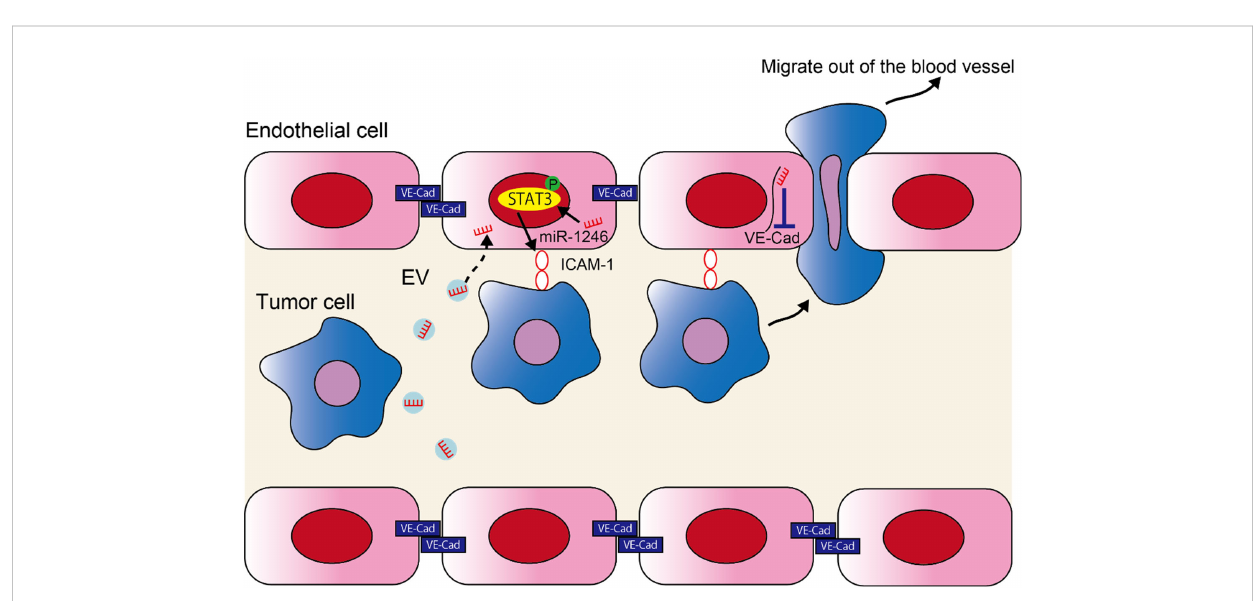
FIGURE 5 miR-1246 in high metastatic tumor EVs promotes metastasis by promoting the adhesion of tumor cells and destruction of the EC barrier. A schematic diagram of the study. miR-1246 released from high metastatic tumor cells via EVs is taken up by ECs and induces ICAM-1 expression via STAT3 activation, which promotes tumor cell adhesion to ECs. Furthermore, miR-1246 destroys the EC barrier by suppressing VE-Cadherin expression and promotes the transendothelial migration of tumor